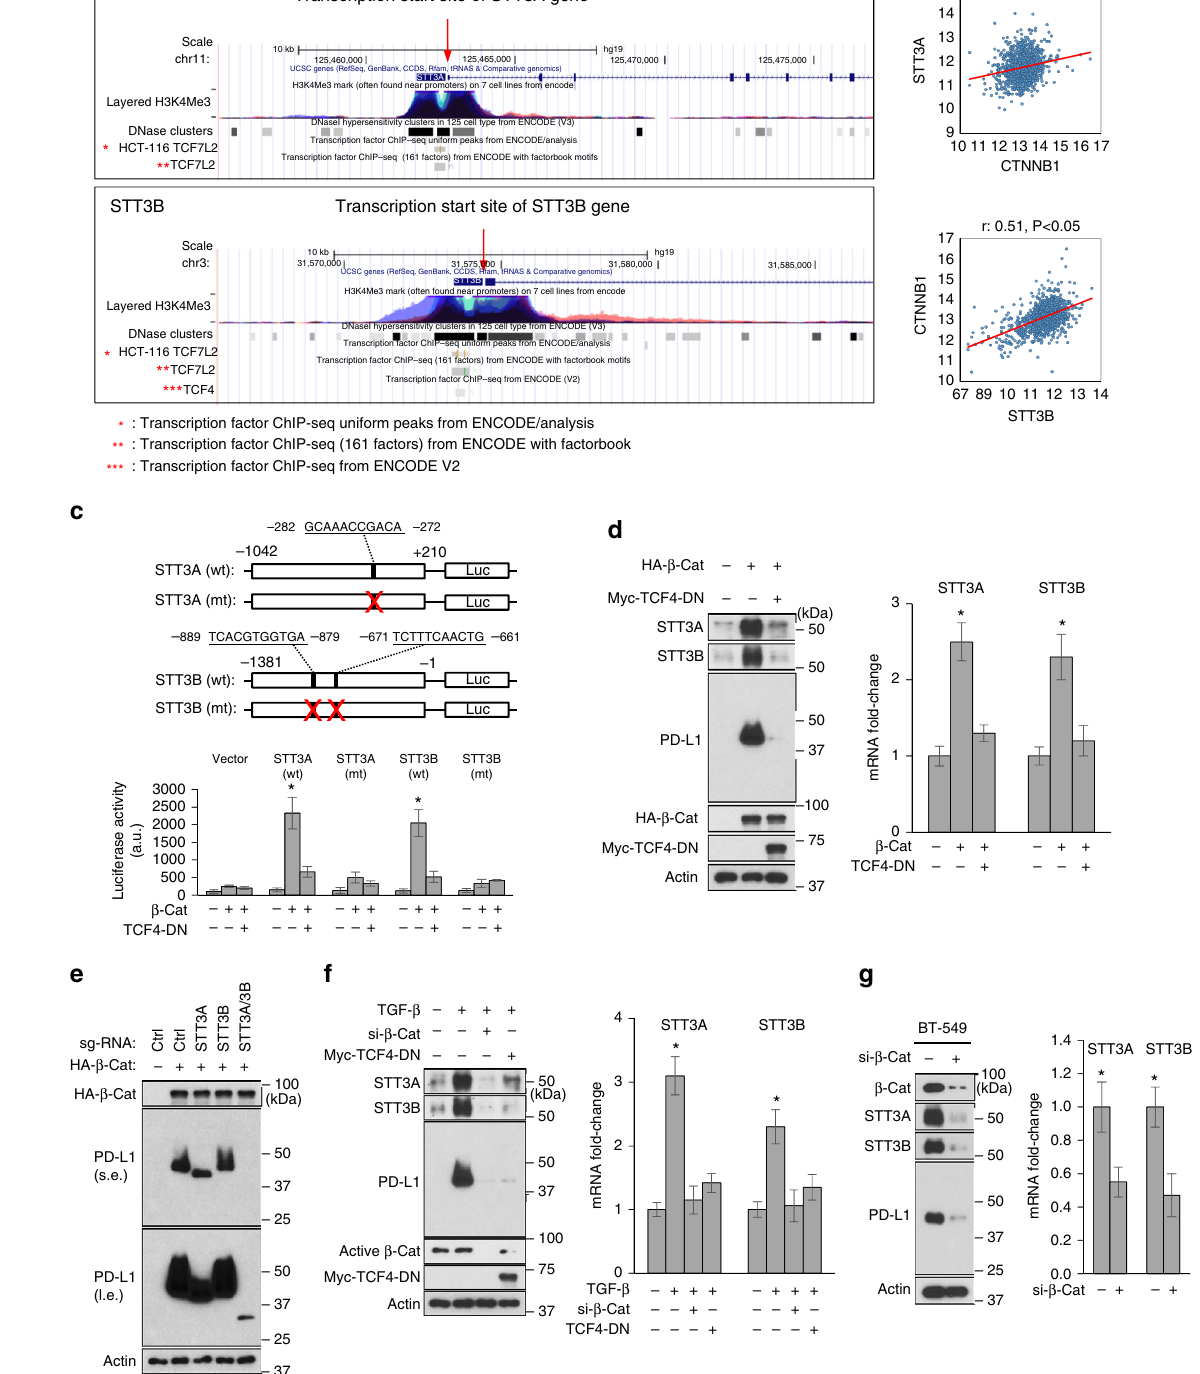
microenvironment, serial dilutions of viable sphere cells in